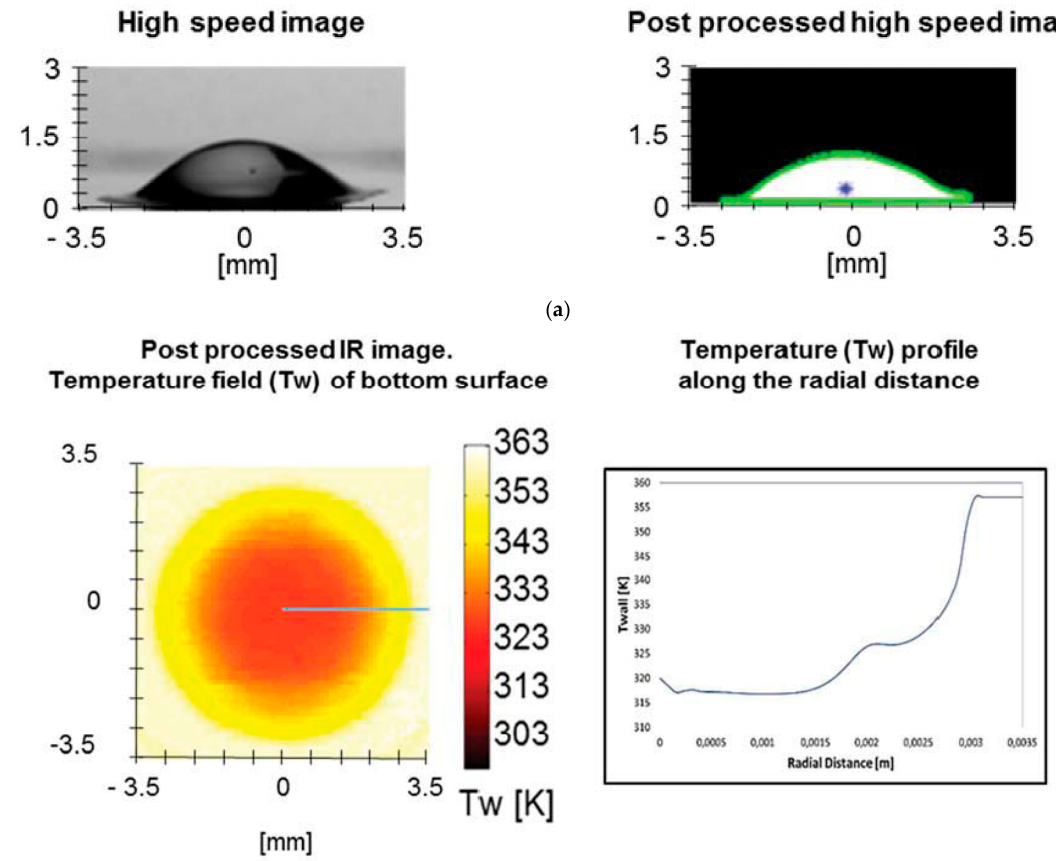
Figure 3. Illustrative representation of a raw and post-processed high-speed image ( a ). Corresponding infrared thermography and relative temperature profile along the radial direction ( b ). The blue line in the infrared thermography indicates the radius along which the temperature is measured. The green curve in the post-processed high-speed image, indicates the definition of the interface of the droplet.